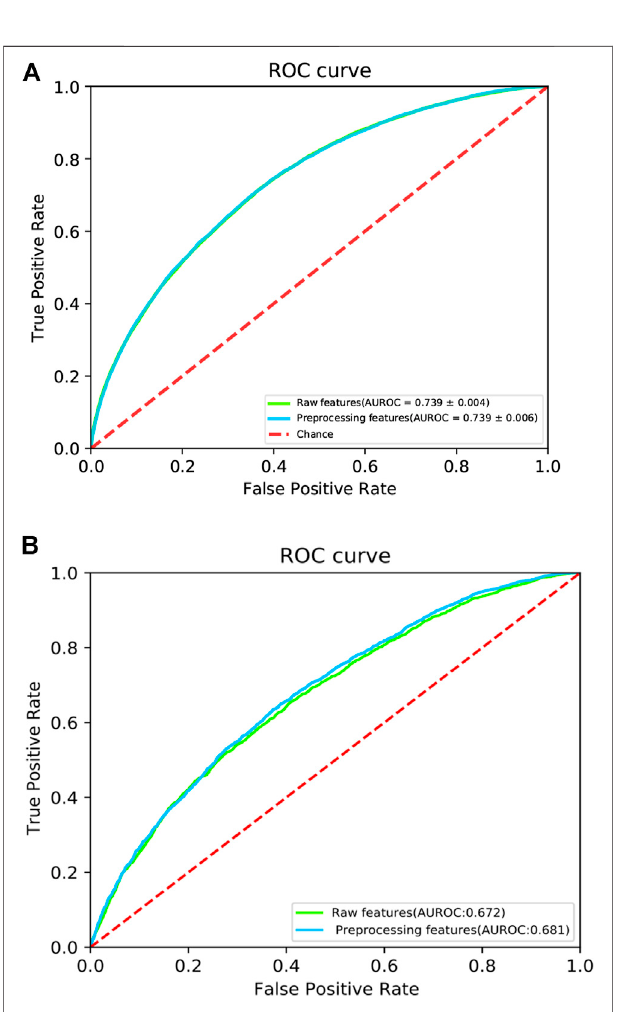
FIGURE 3 | The ROC curves of (A) 5-fold cross validation and (B) independent test. The red dotted line is a control line on which AUROC (cid:1) 0.5.